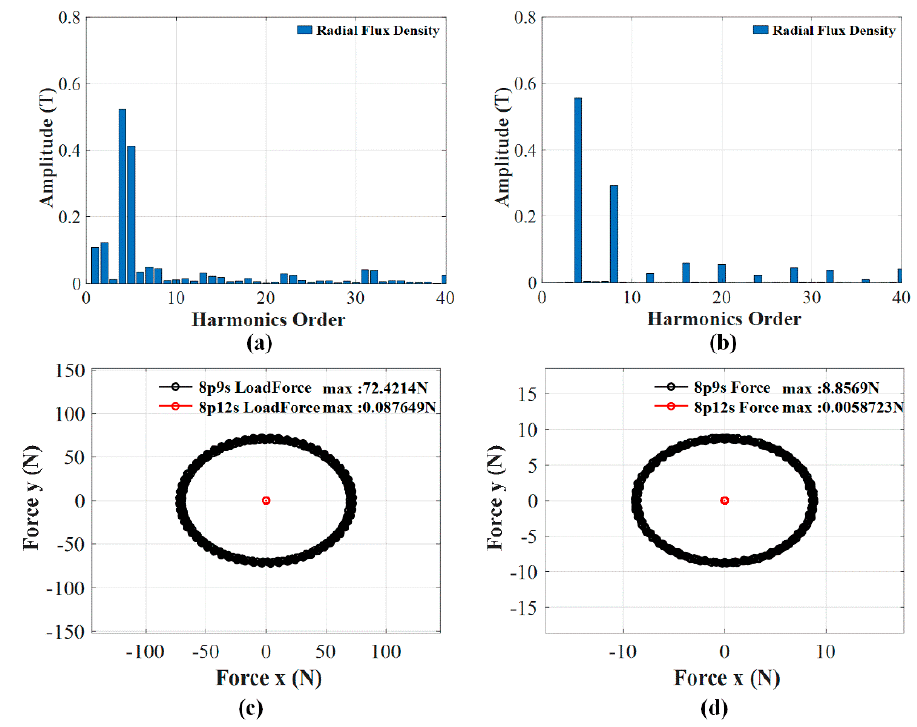
Figure 4. Comparison of the analysis results of permanent magnet machines with two different pole/slot combinations: ( a ) harmonics orders of radial flux density 9-slots, ( b ) harmonics orders of radial flux density 12-slots ( c ) UMF of no-load, and ( d ) UMF of rated-load.